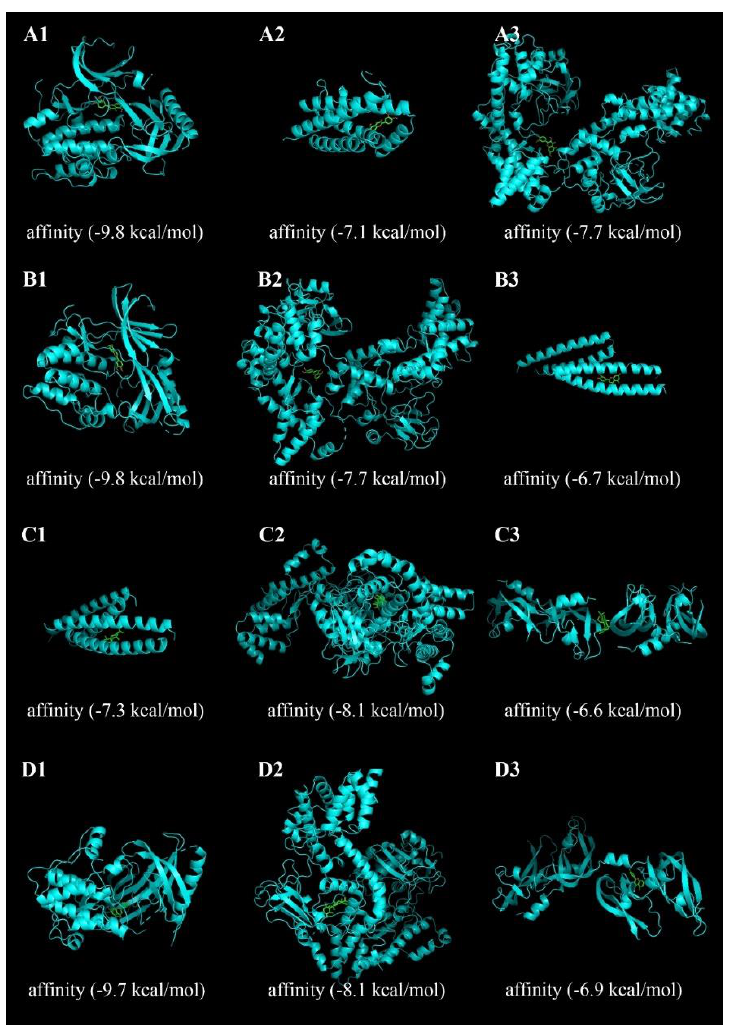
Figure 6. Molecular docking of compounds with core targets. ( A1 – A3 ) Docking process of quercetin with AKT1, IL-6, and RELA, respectively. ( B1 – B3 ) Docking process of luteolin with AKT1, REAL, and JUN, respectively. ( C1 – C3 ) Docking process of apigenin with JUN, RELA, and VEGFA, respectively. ( D1 – D3 ) Docking process of ursolic acid with AKT1, RELA, and VEGFA, respectively.